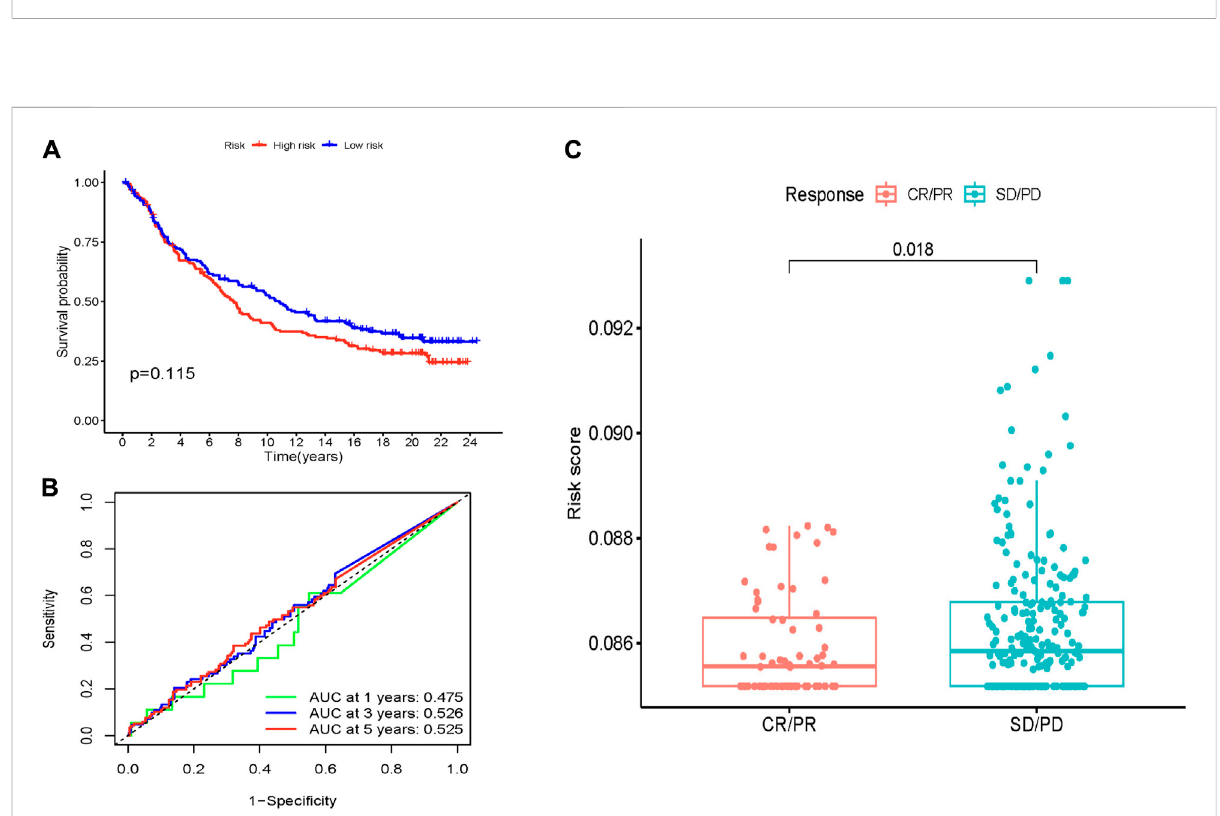
FIGURE 8 PredictivevalueofMCRLncsforimmunotherapyresponseintheIMvigor210cohort. (A) Kaplan-Meierestimatesofoverallsurvivalforpatientsin the low-risk or high-risk groups suggest that survival in the low-risk group was not statistically signi fi cant. (B) In the IMvigor210 cohort, the AUC values ofthemolecularchaperones-relatedlncRNAprognosticmodelscreenedbyLasso regressionat1,3and 5 yearswere0.475, 0.526 and0.525, respectively. (C) Comparison of risk scores between partial response and progressive disease suggests that lower MCRLncs scores may predict better immunotherapy